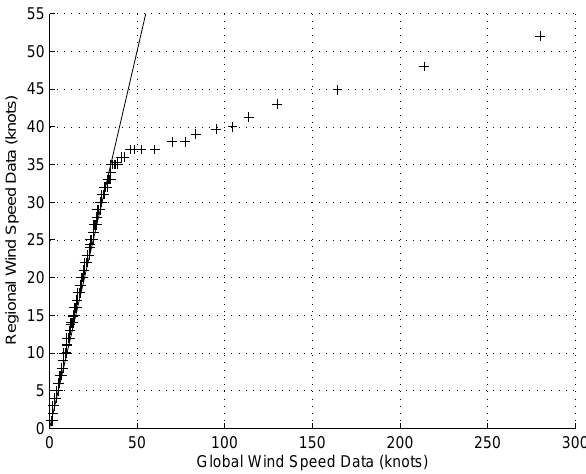
Fig. 6. The 850mb-wind speed over MP from Wyoming data archive after screening with the threshold v max (52.1knots) plotted against the wind speed from IGRA database for the same stations and period. Each ordered pair denoted by a cross refers to the same 0.01%-quantile in both datasets. The straight line shows where the crosses should lie if both datasets had the same